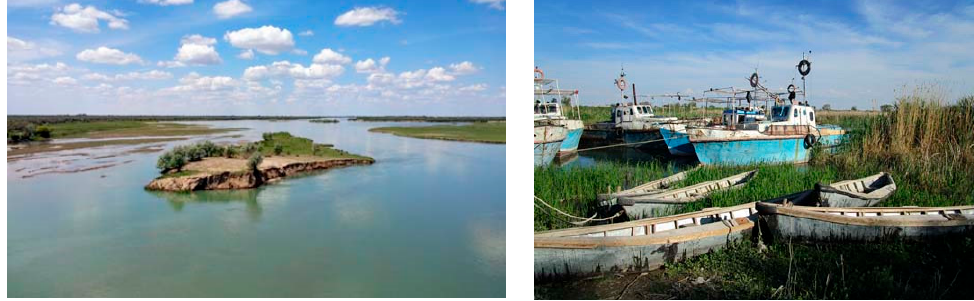
Figure 5. ( Left ): The Ili River near Akzhar, Kazakhstan; ( Right ): Fishing boats on the channel to Lake Balkhash at Kuygan, Kazakhstan. Balkhash at Kuygan,